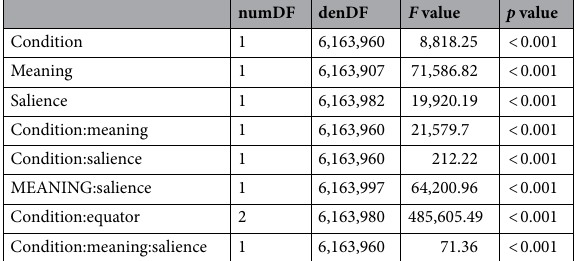
Table 1. Linear mixed effects model results summary. Main effects, two-way interactions, and three-way interaction of fixed effects included in linear mixed regression using the model formula: gaze ~ condition*meaning*salience + condition:equator + (1 | scene). We observed significant main effects of condition, meaning, and salience on gaze, significant condition:meaning and condition:salience interactions, and critically, a significant three-way interaction between condition, salience, and